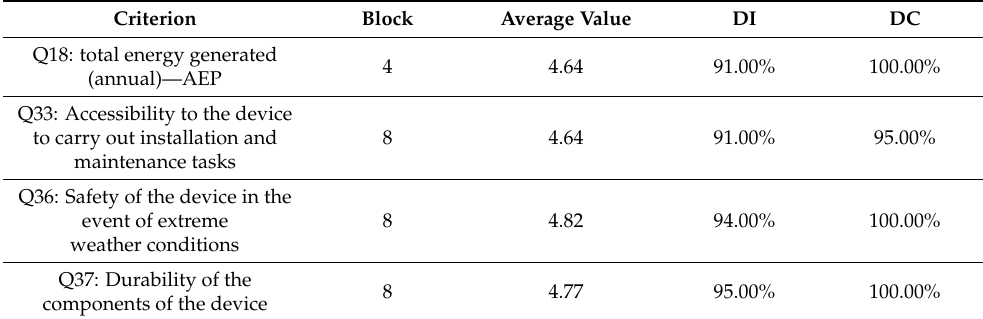
Table 8. Criteria meeting DI ≥ 90% and DC ≥ 90% values.